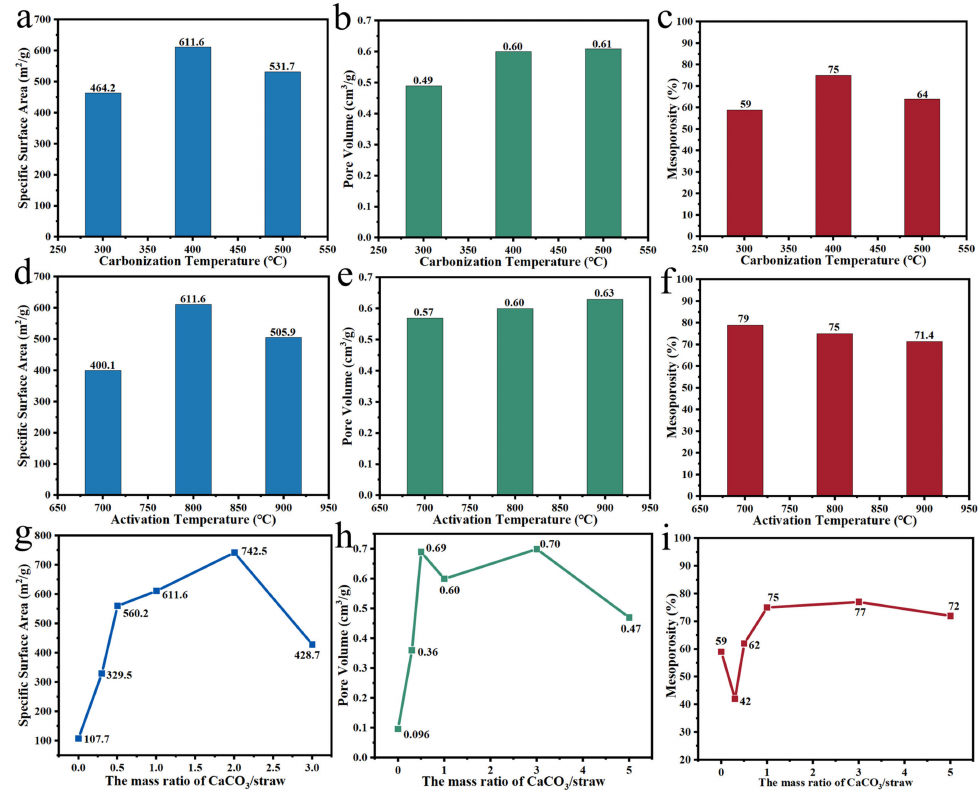
Figure 14. ( a – c ) Impact of the carbonization temperature on CaCO 3 activation effect; ( d – f ) Impact of the activation temperature on CaCO 3 activation effect; ( g – i ) Impact of the mass ratio of CaCO 3 /straw on CaCO 3 activation effect